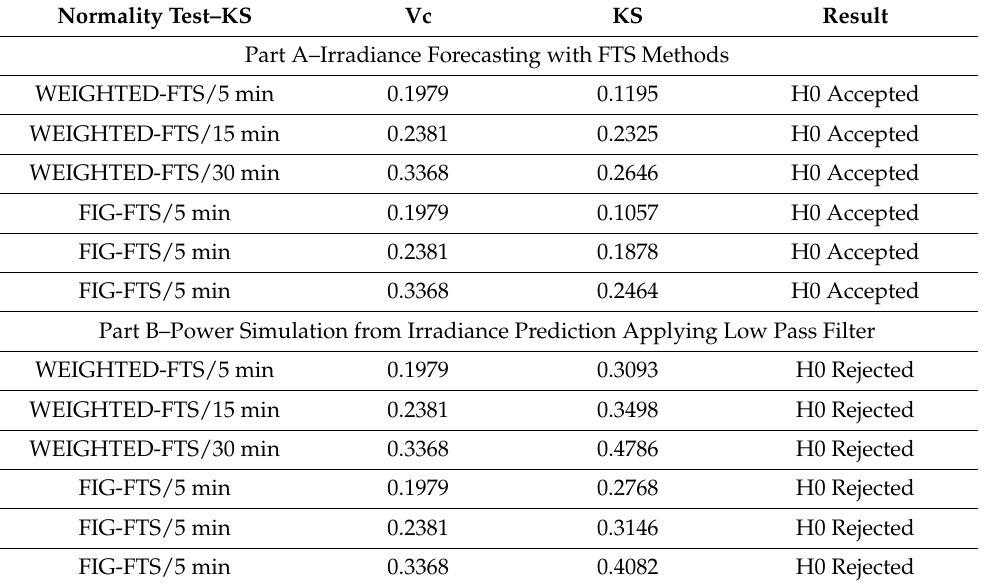
Table 8. Kolmogorov-Smirnov Test